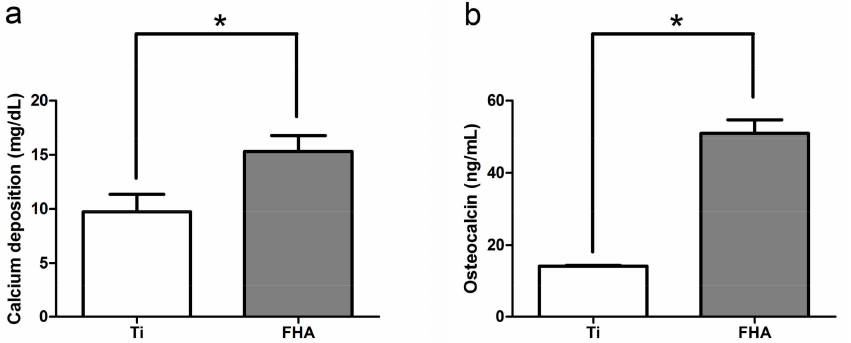
Figure 6. ( a ) Calcium deposition and ( b ) osteocalcin production in cells seeded on Ti and FHA-coated discs. * p <